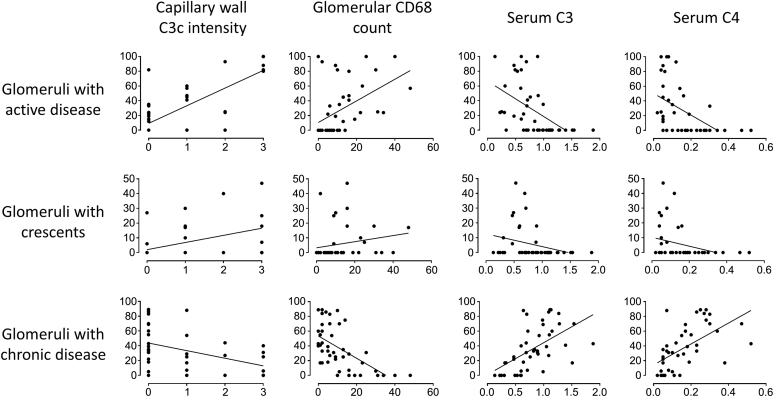
Correlation of complement C3c staining intensity, maximum glomerular CD68 count, and serum complement markers with renal biopsy features. The percentage of glomeruli with active disease correlated significantly with capillary wall C3c staining intensity (r = 0.66, P < 0.00001), maximum glomerular CD68 count (r = 0.75, P < 0.0000001), serum C3 (r = −0.65, P < 0.00001), and serum C4 (r = −0.62, P < 0.00001). The percentage of glomeruli with crescents correlated significantly with capillary wall C3c staining intensity (r = 0.48, P = 0.002), maximum glomerular CD68 count (r = 0.45, P = 0.003), serum C3 (r = −0.38, P = 0.01), and serum C4 (r = −0.38, P = 0.01). The percentage of glomeruli with chronic disease correlated significantly with capillary wall C3c staining intensity (r = −0.41, P = 0.01), maximum glomerular CD68 count (r = −0.61, P < 0.0001), serum C3 (r = 0.68, P < 0.000001), and serum C4 (r = 0.69, P < 0.000001).